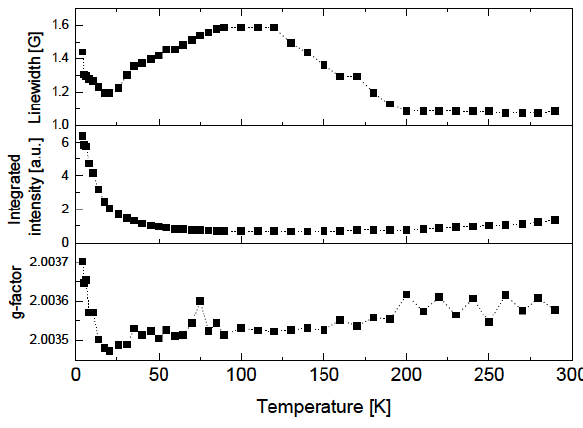
Figure 10: Temperature dependence of the product of integrated intensity and temperature for the N component in all investigated